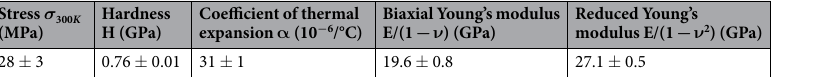
Table 1. Thermomechanical properties of BiI 3 obtained by nanoindentation and thermally induced bending techniques: stress at 300 K ( σ 300K ), hardness (H), coefficient of thermal expansion (CTE or α ), and biaxial [E/ (1 − ν )] and reduced [E/(1 − ν 2 )] Young’s